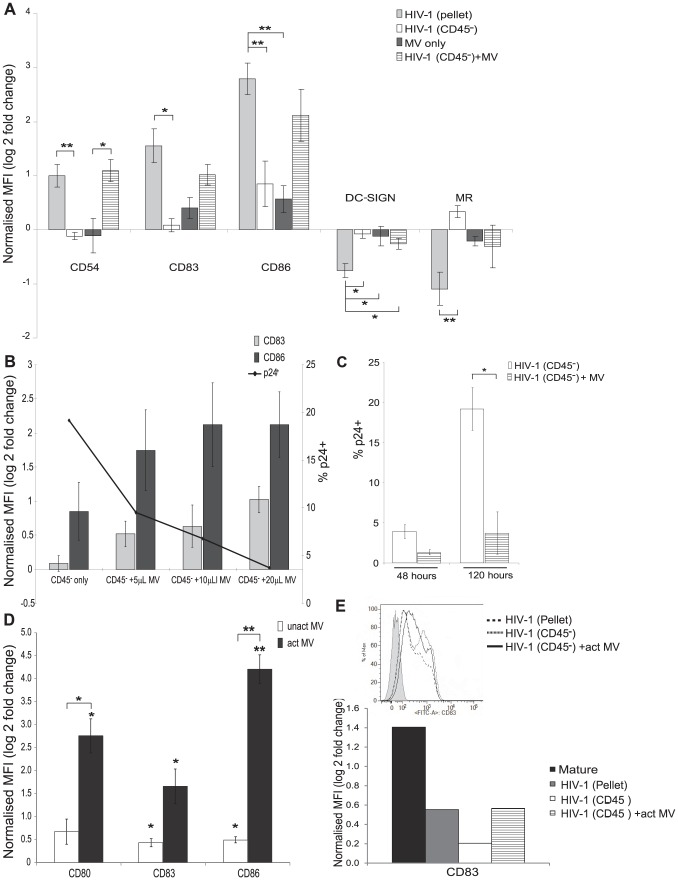
Addition of microvesicles to HIV-1BaL(CD45−) restores MDDC maturation.MDDCs were either treated with HIV-1BaL(pellet), HIV-1BaL(CD45−) alone, CD3/CD28 activated MVs (20 µl/3.5×105 cells) alone or HIV-1BaL(CD45−) with the addition of CD3/CD28 activated MVs for 48 hours. To calculate the MV ‘inoculum’ the CD45 concentration of the MVs preparation was matched to the CD45 concentration of the HIV-1BaL(pellet) stock (see Table 1). A) The expression of maturation markers was determined by flow cytometry and compared to the maturation seen with the HIV-1BaL(pellet) stock (mean +/− SEM, n = 3, *p<0.05 **p<0.01). B) The expression of CD83 and CD86 was assessed and there was a positive correlation between amount of MVs added and the level of maturation seen in HIV-1 exposed MDDCs (mean +/− SEM, n = 3, CD83: p = 0.78, r = 0.9 and CD86: p = 0.27, r = 0.87). The level of p24+ cells was also measured by flow cytometry. C) The proportion of HIV-1 infected MDDCs at 120 hours was reduced by addition of MVs to the HIV-1BaL(CD45−) inoculum (mean +/− SEM, n = 3, *p<0.05). D) MVs from anti CD3/CD28 activated primary T lymphocytes also induce MDDC maturation. MDDCs (0.5×106 cells/mL) were treated with MVs from CD3/CD28 activated or non-activated primary T lymphocytes at the same concentration as in panel A for 48 hours and expression of CD80, 83 and 86 measured by flow cytometry (mean +/−SEM, n = 3, *p<0.05, **p<0.01 compared to mock or, where bracketed, activated MVs are compared to non-activated MVs). E) HIV-1BAL(pellet) and MVs+HIV-1BAL(CD45−) also induce maturation of primary blood myeloid DCs. Blood myeloid BDCA1 DCs (0.5×106 cells/mL) were isolated from blood and exposed to maturation mix, HIV-1BAL(pellet), HIV-1BAL(CD45−) and HIV-1BAL(CD45−)+MVs from activated SUPT1.CCR5-CL.30 cells at similar concentrations to panel A. CD83 expression was measured by flow cytometry. Representative histogram of three separate experiments.